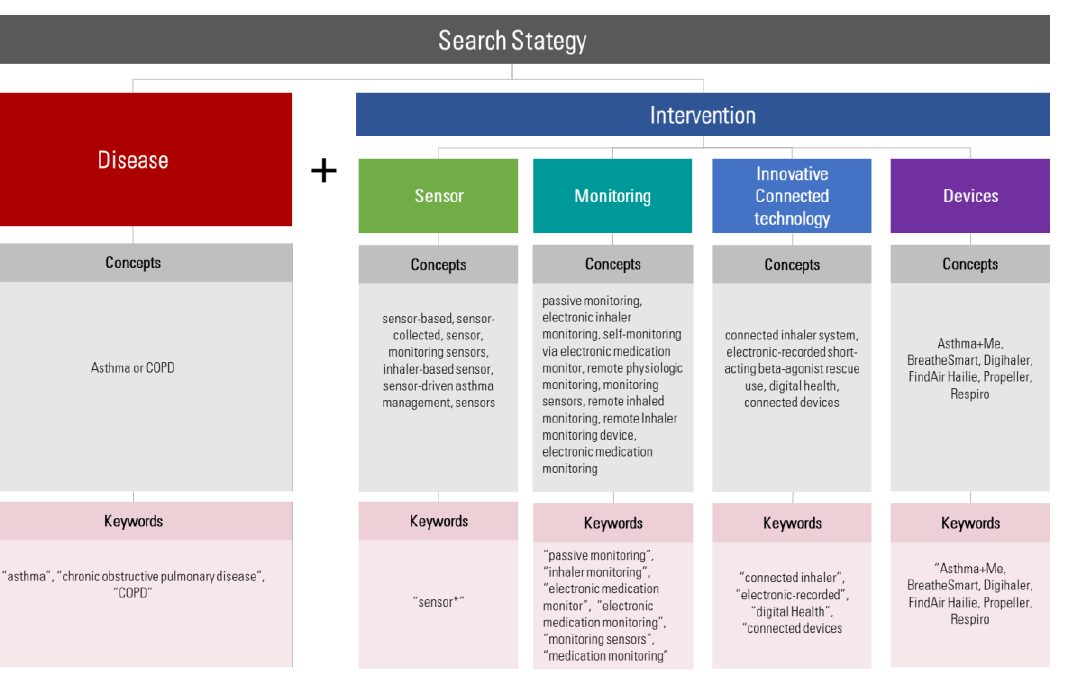
Figure 1. Search strategy summary.